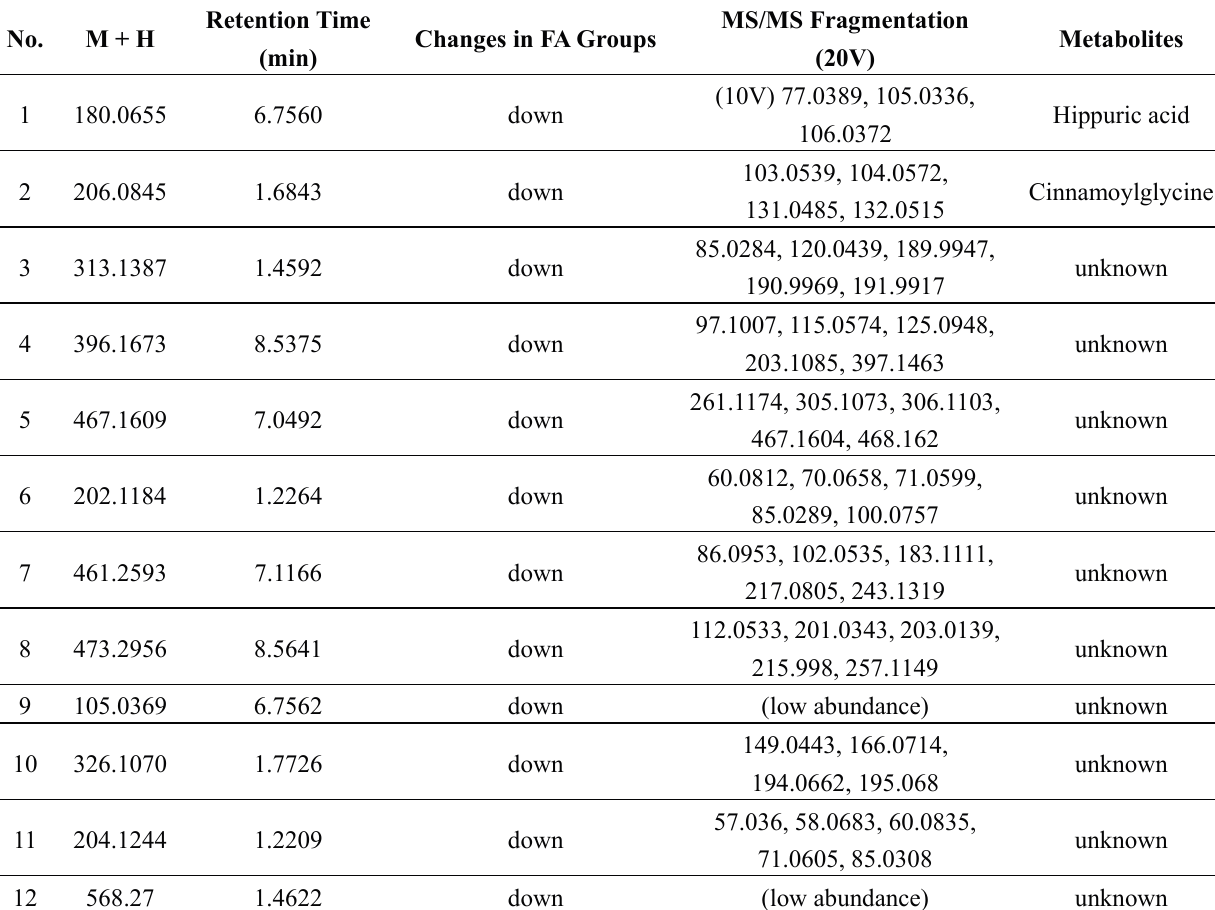
Table 3. Identification of significantly different metabolites in the urine of mice by LC-TOF-MS